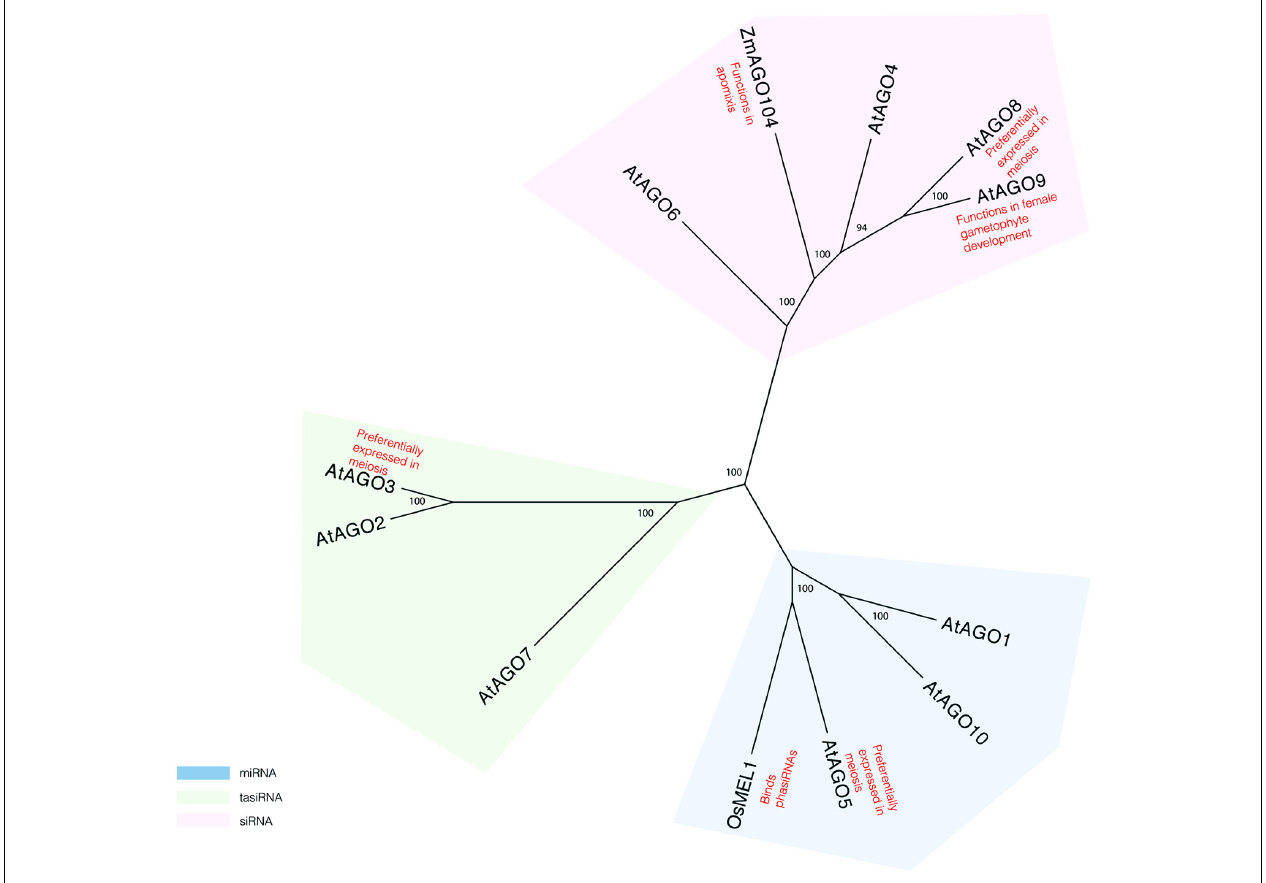
FIGURE 1 | Phylogeny reconstruction of Arabidopsis AGO proteins and some of their homologs in maize and rice. Maximum likelihood bootstrap support values are displayed next to branches. Only values above 70 are shown.